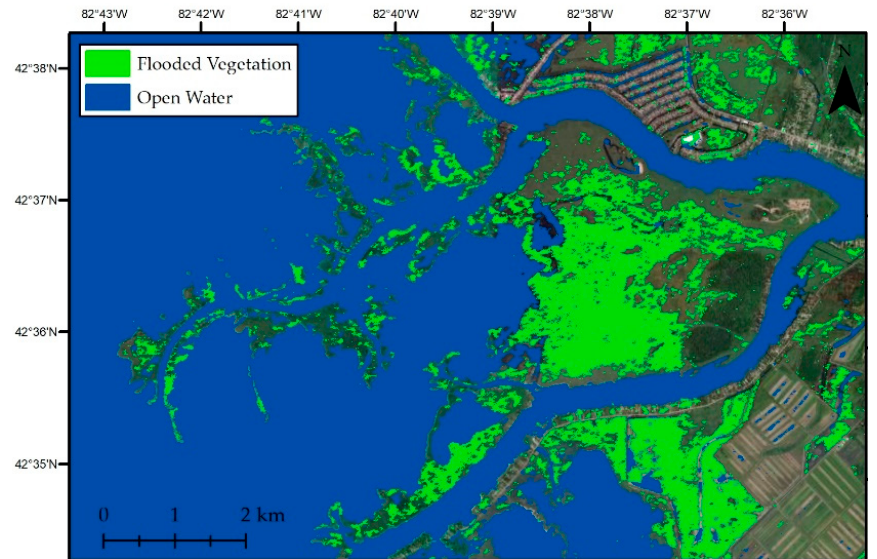
Figure 2. Surface water and flooded vegetation extent map for 23 July 2017 for the St. Clair River Delta.